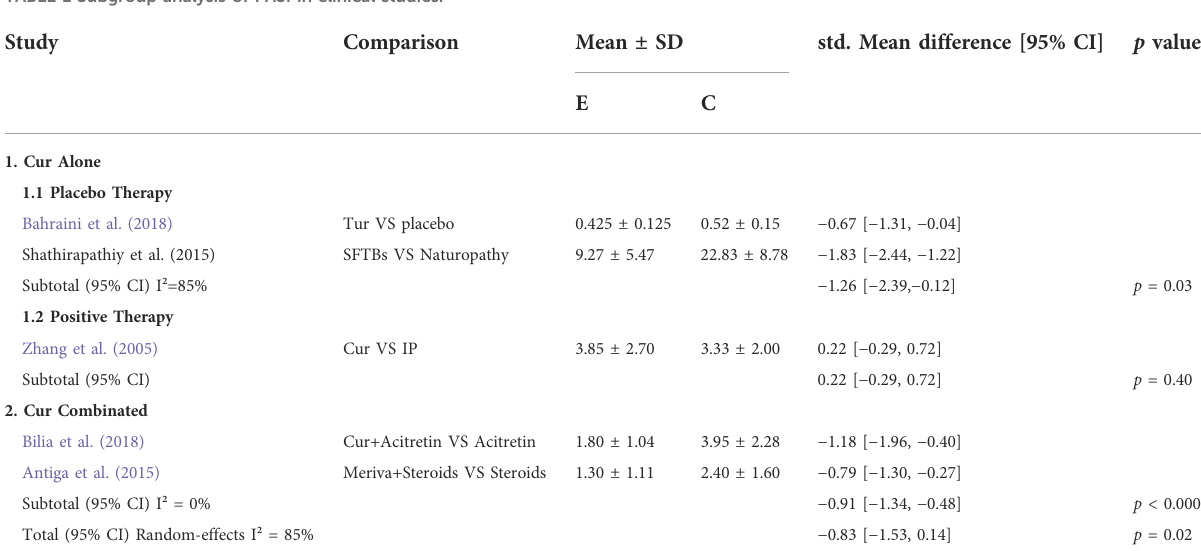
TABLE 1 Subgroup analysis of PASI in clinical